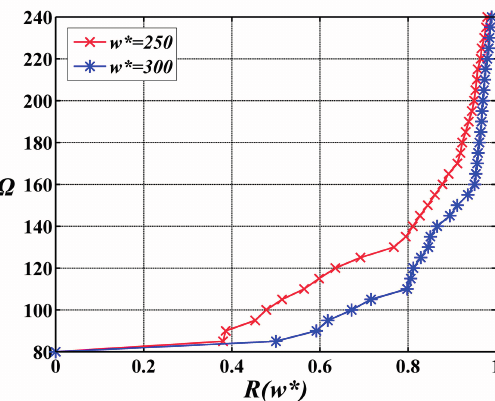
Figure 5. The cost-reliability curves with alterations in the cost from 80 to 240 under the two expected execution times w * = 250 and w * = 300 given by